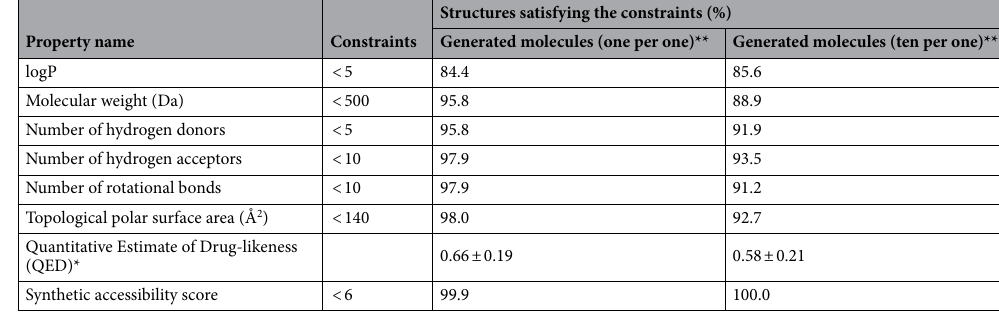
Table 5. Percentage of generated molecules falling within plausible drug-like molecule ranges of values. *There is no common threshold for QED. QED varies in a range [0,1]. The higher a QED value is, the better. The columns show mean values and standard deviations. **Averaged across five cross validational